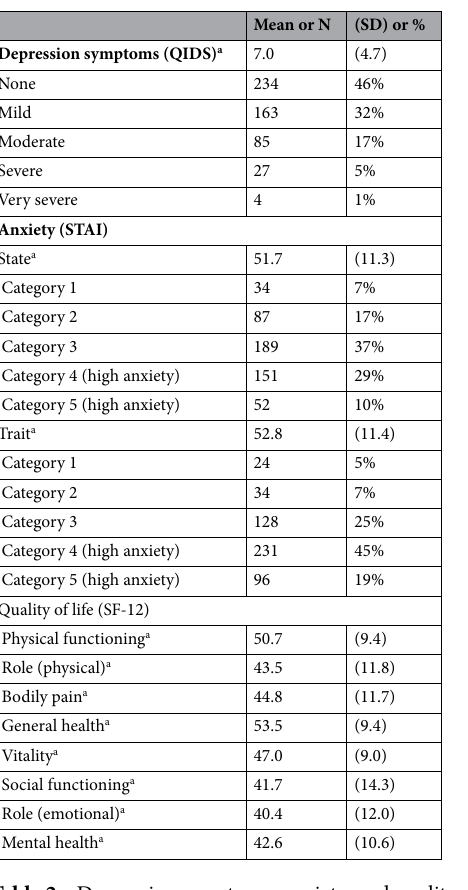
Table 2. Depressive symptoms, anxiety, and quality of life among participants ( n = 513). a Mean and standard